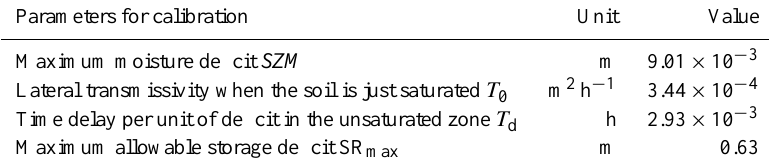
Table 2. Main parameter values for